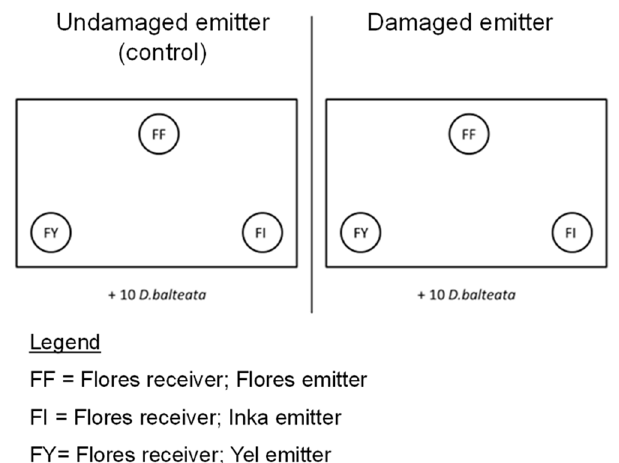
Figure 4. Design of the choice test feeding assay. For each treatment (damaged, n = 15; undamaged, n = 15), three receiver plants from the same population were put in a cage alone with 10 D. balteata adults for 24 h. Five replicate cages for each combination were used.